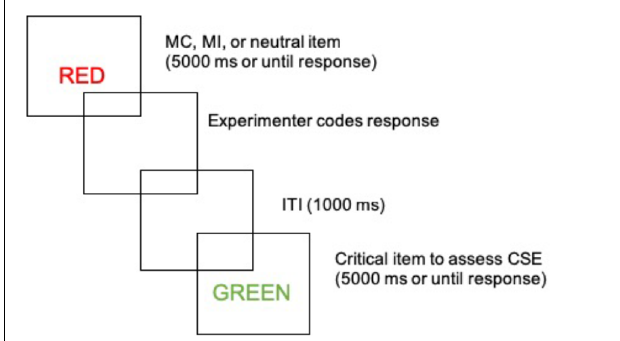
FIGURE 1 | Illustration of task